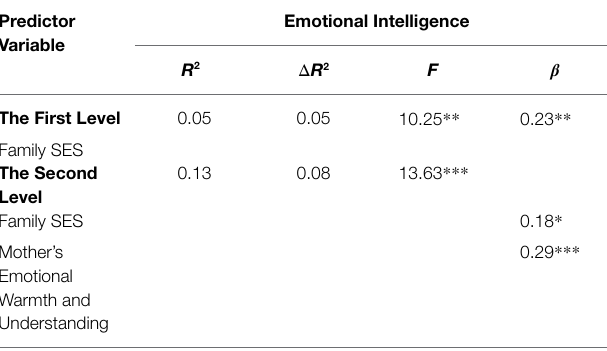
TABLE 8 | Regression analysis of Jingzhou primary school students’ emotional intelligence on family socioeconomic status, mother’s emotional warmth, and